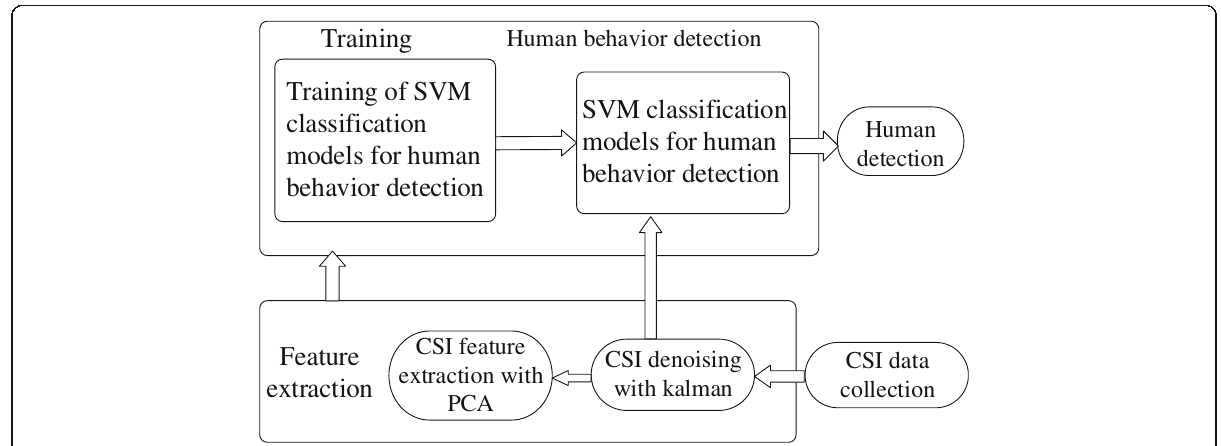
Fig. 5 System architecture of PCA-Kalman